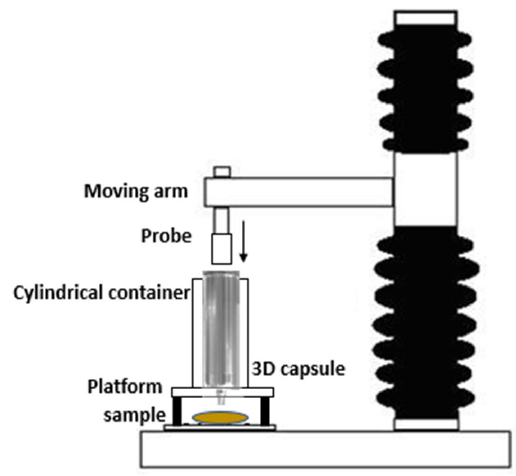
Figure 1. Force of extrusion